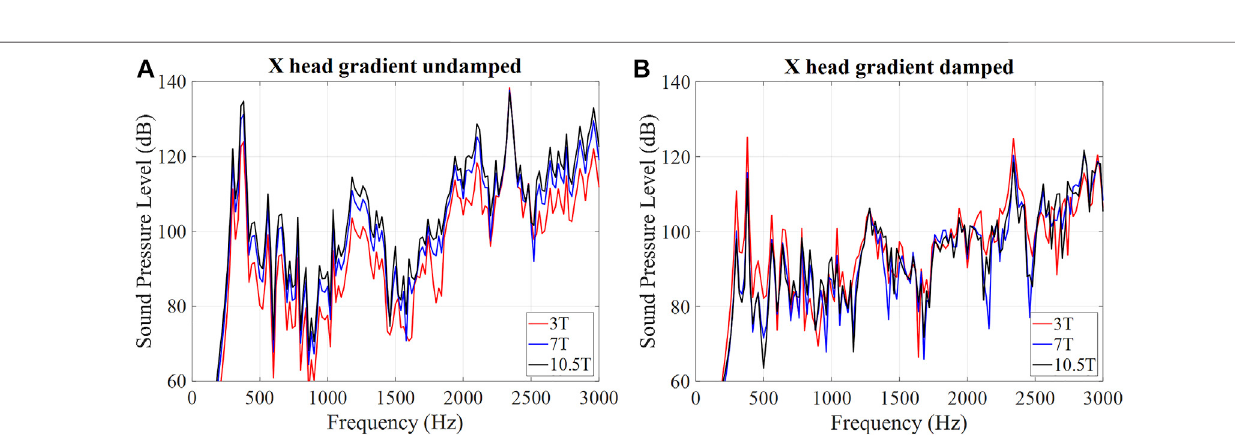
Frontiers in Physics |